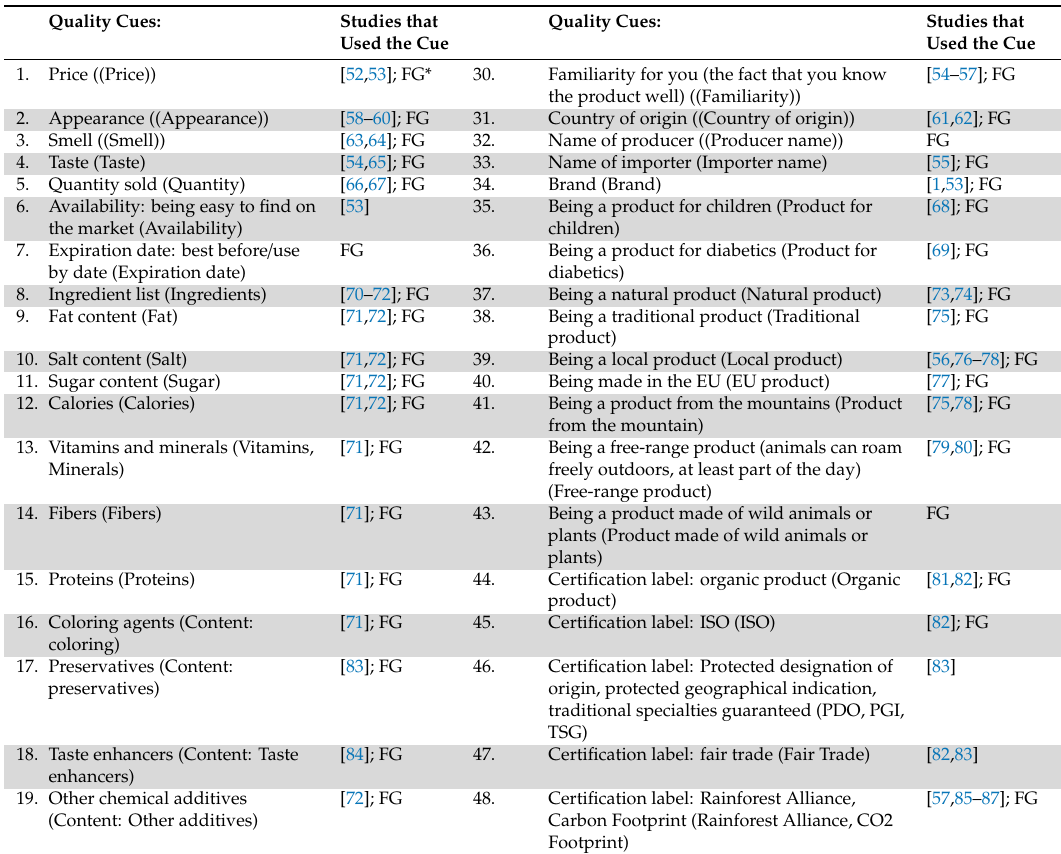
Table 1. Quality cues used in the present investigation and some of the studies where they were previously